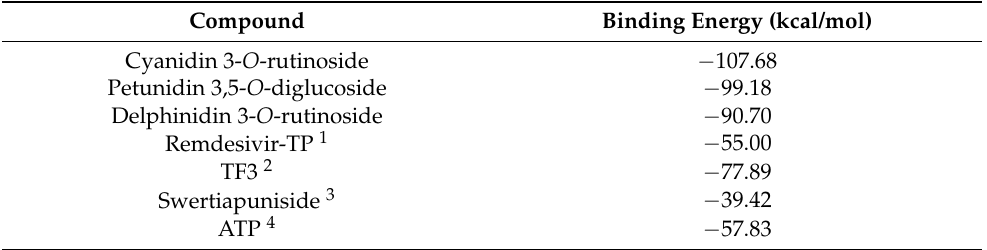
Table 1. The estimated binding energies of the top three polyphenols and the control compounds.